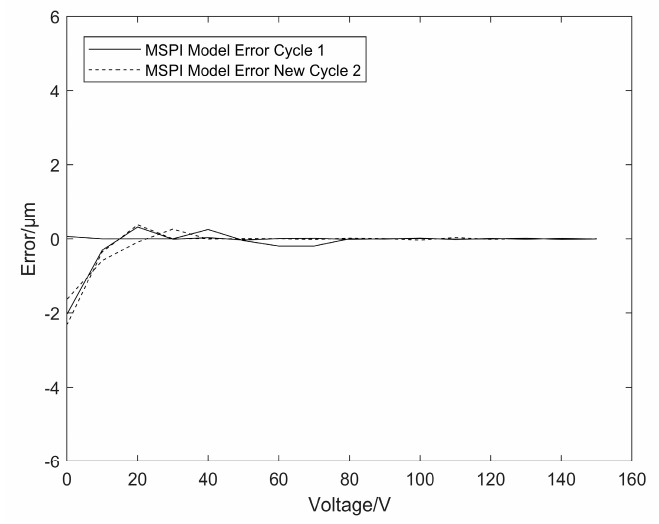
Figure 23. Modeling error of MSPI model